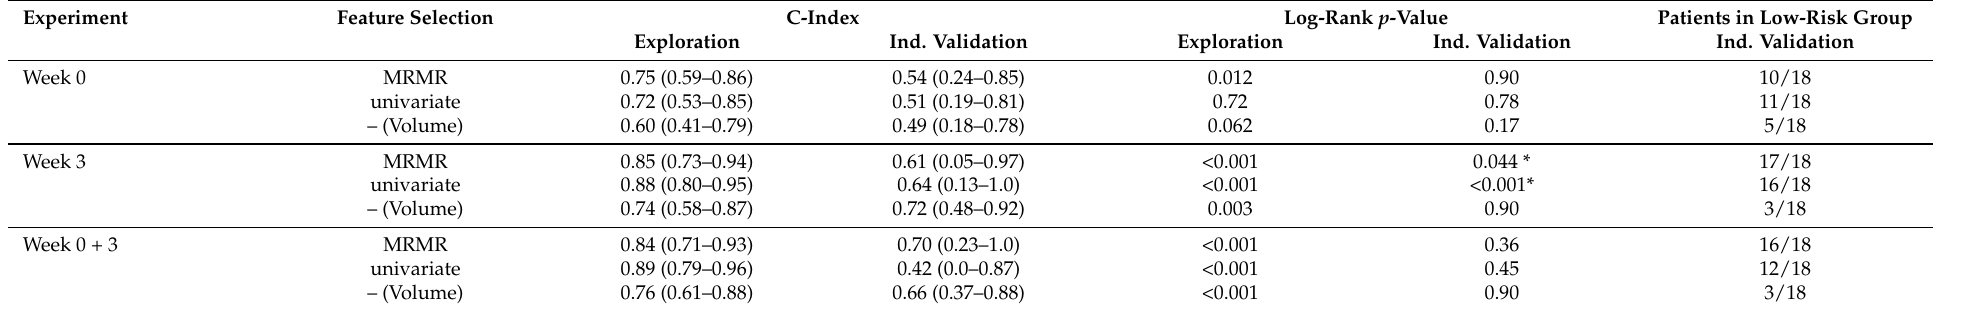
Table 4. Final signature model performance (FDG-PET): Values in parenthesis denote 95% confidence intervals based on bootstrapping. Values in bold denote the best performance (C-index) and statistically significant stratification (Log-rank p -value) for the independent validation cohort. For each experiment, the last row shows the performance of a baseline model that used tumor volume as a feature. The last column provides the fraction of patients assigned to the low-risk group based on the prediction cutoff. The number of patients in the low-risk group of the exploratory cohort is always 18 out of 37, as the median prediction was used as the cutoff. * indicates statistically significant p -values for the stratification that produced highly imbalanced groups for low and high risk of loco-regional recurrence.